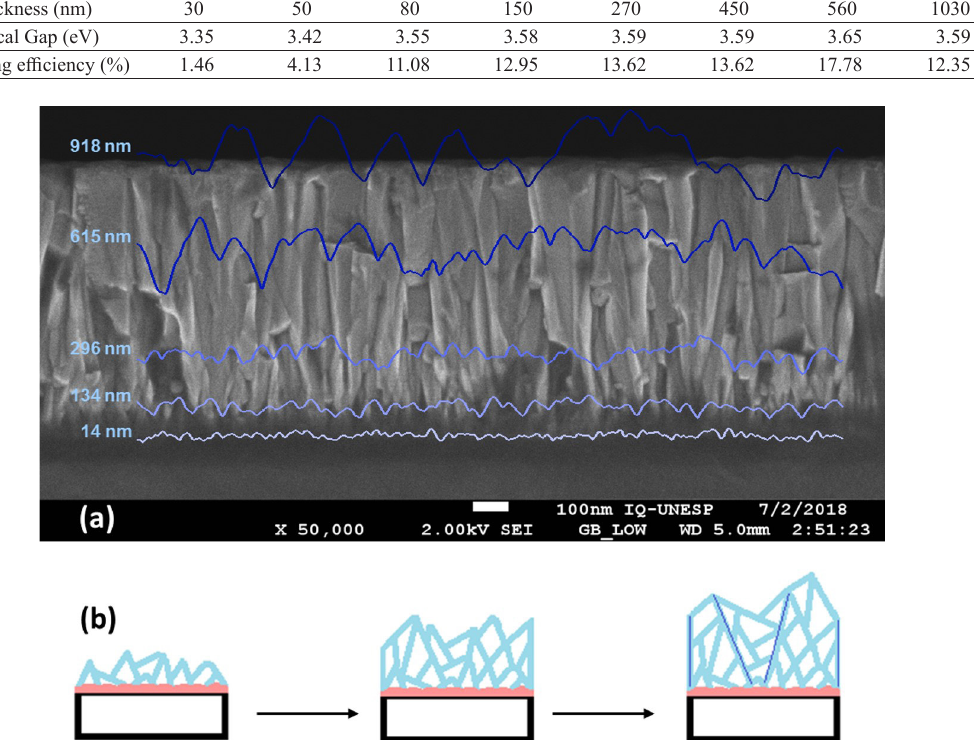
Figure 5. (a) Scanning electron micrographs; (b) AFM-derived schematic profiles (not to scale), illustrating how the film structure changes with growth.